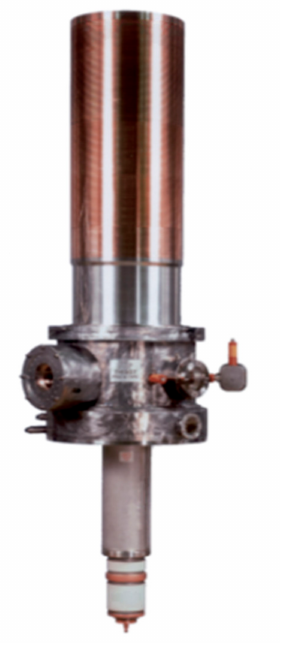
Figure 1. TH1507 140GHz W-7X dedicated gyrotron.